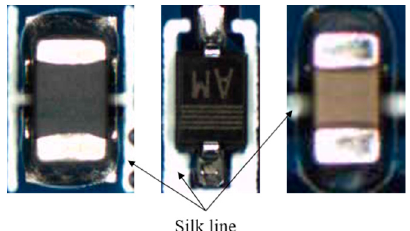
Figure 5. PCB background patterns in chip component images. The silk line is printed on the PCB to provide additional information about the component. Silk lines can adversely affect defect classifications because of their similarity to solder region.